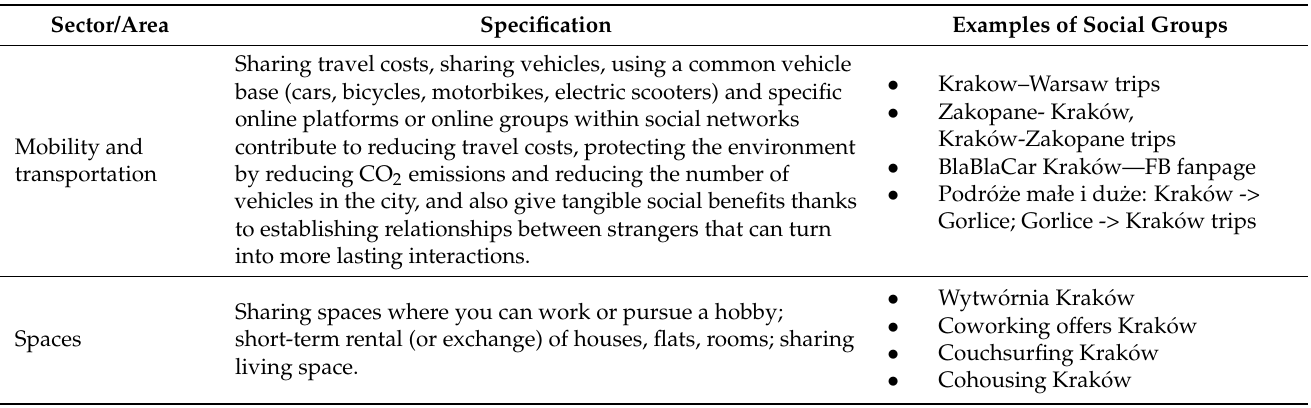
Table 5. Virtual sharing economy groups acting in support for integration of the local communities.